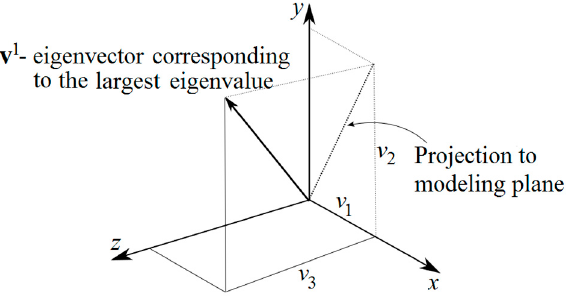
Figure 2. Eigenvector of principal fiber orientation.